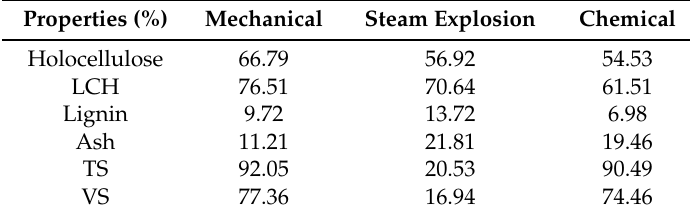
Table 1. Properties of rice straw under different